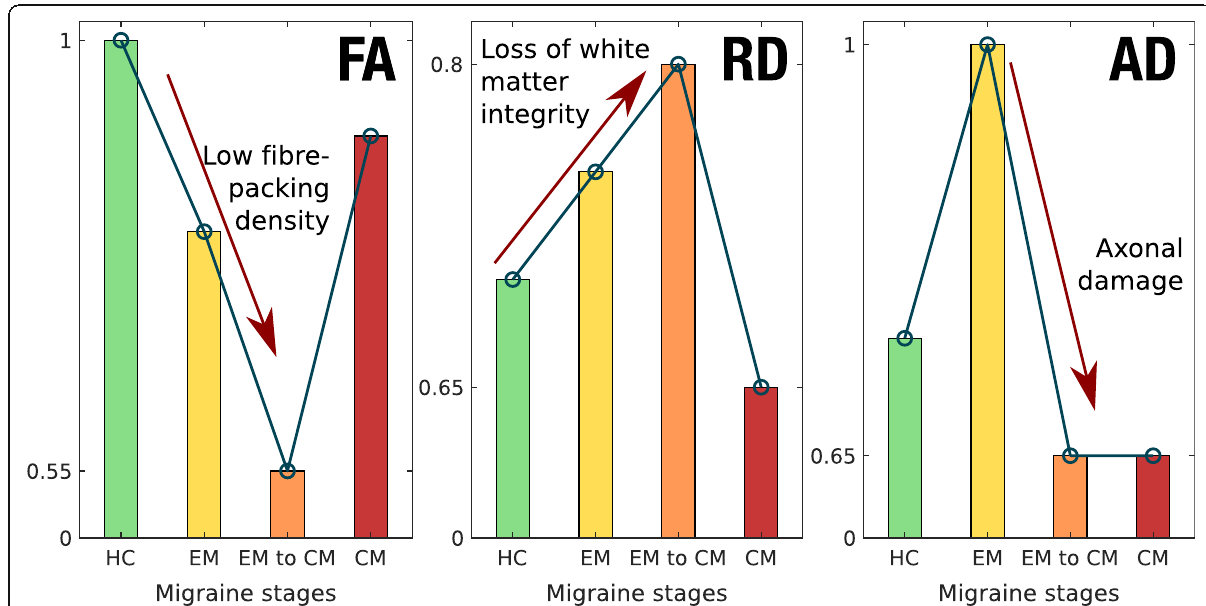
Fig. 3 DTI measures temporal change hypothesis. Illustrative values are shown for generalized trends in FA, RD and AD (from left to right) in each of the different migraine stages, including a previous healthy control stage. Stages are ordered chronologically from left to right in each subplot. The interpretation of different trends in DTI measures is given in each subplot. The values in the vertical axes should only be used as an orientation to watch the trends and differences between groups, not interpreted as real